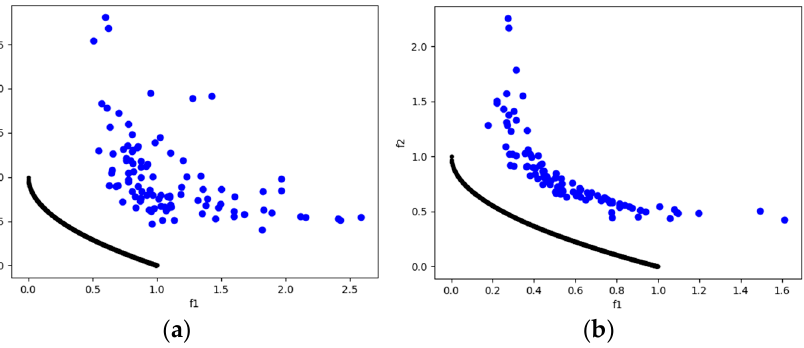
Figure 11. The plots of the approximate PFs with the highest HV value against real PF. ( a ) UF3 approximate PF using MOSA/D-CGO; ( b ) UF3 approximate PF using MOSA/D-DE.